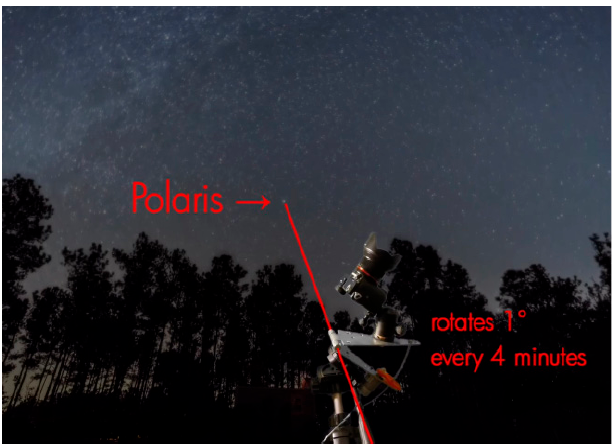
Figure 20. Working model of a Barn Door Tracker, a self-made tracker setup.